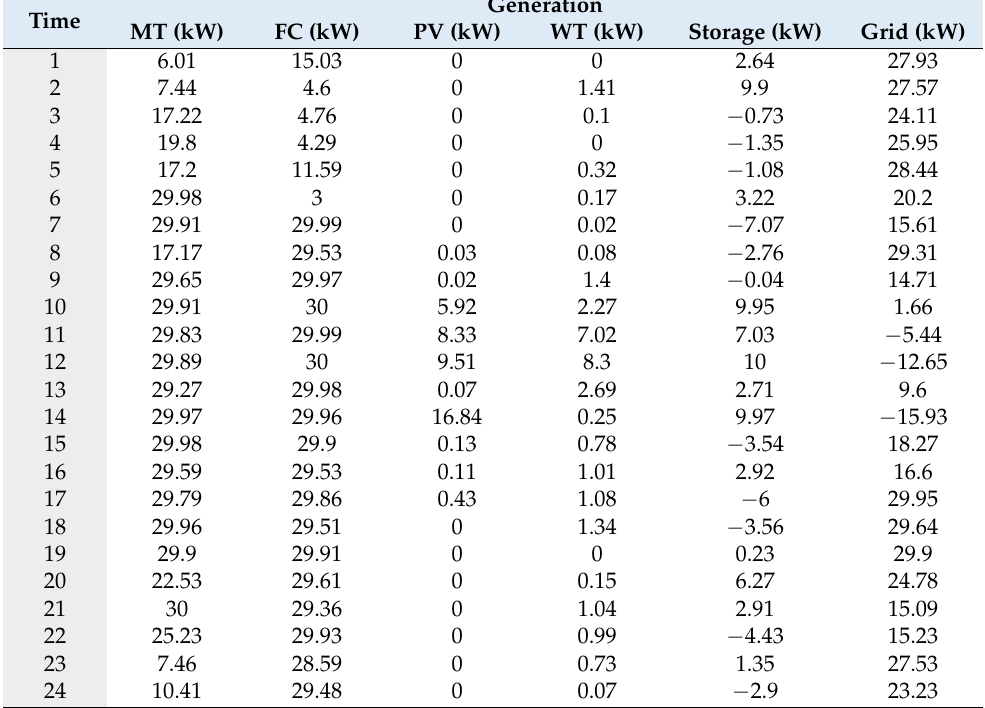
Table 9. Power distribution for reducing costs and considering the limitations of the upstream network